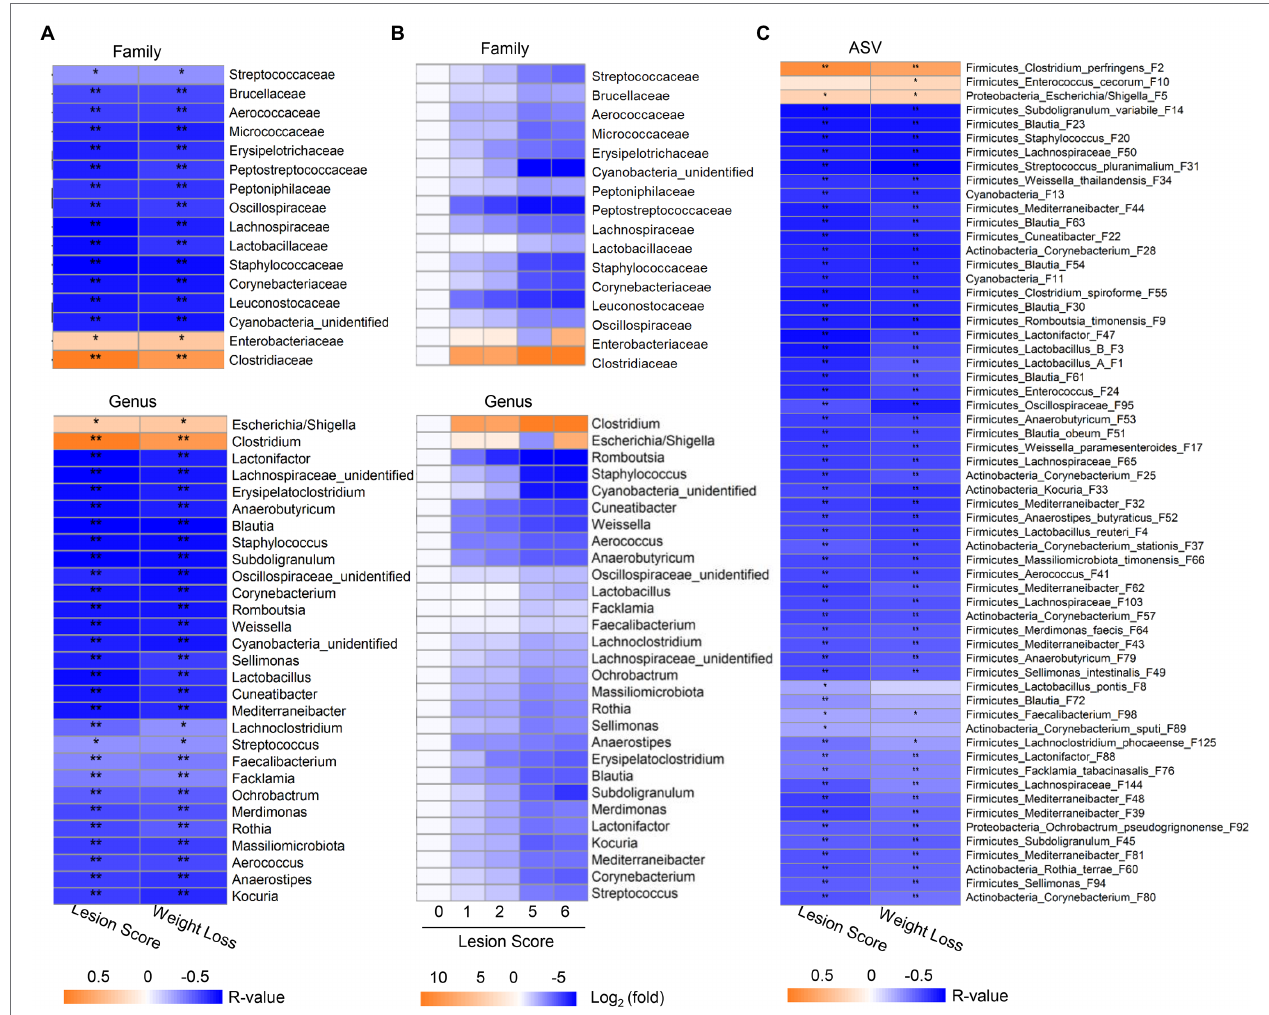
FIGURE 4 | Correlation between relative abundance of the ileal bacteria and the severity of NE. The Spearman correlation analysis was performed between the ileal microbiota profile and the intestinal lesion score and weight loss during days 10–17. (A) Spearman correlation at the family and genus levels. (B) Heatmap showing log2 transformations of the fold changes of the ileal bacteria among different groups of NE at the family and genus levels relative to score-0 healthy controls. (C) Spearman correlation at the ASV level. Significance of Spearman correlation analysis was corrected with the Benjamini-Hochberg procedure. *FDR < 0.05, **FDR <